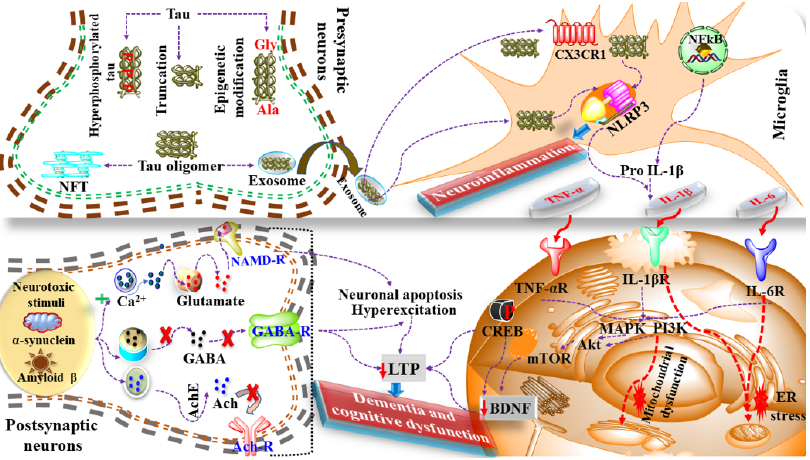
Figure 1. Role of neuroinflammation and dementia. The presence of coexisting neurological disorders such as Alzheimer’s disease, Parkinson’s disease, and exposure to neurotoxic stimulus causes increased chemokines and NLRP3 activation that eventually leads to neuroinflammation. Moreover, neurotoxic stimulus also induces neuroinflammation via modulation of MAPKs, Akt/PI3K, mTOR, ER stress and mitochondrial dysfunction. Additionally, these neurological disorders cause a dysfunctional release of neurotransmitters that further interferes with the function of CREB, BDNF, LTP, etc., and causes dementia.